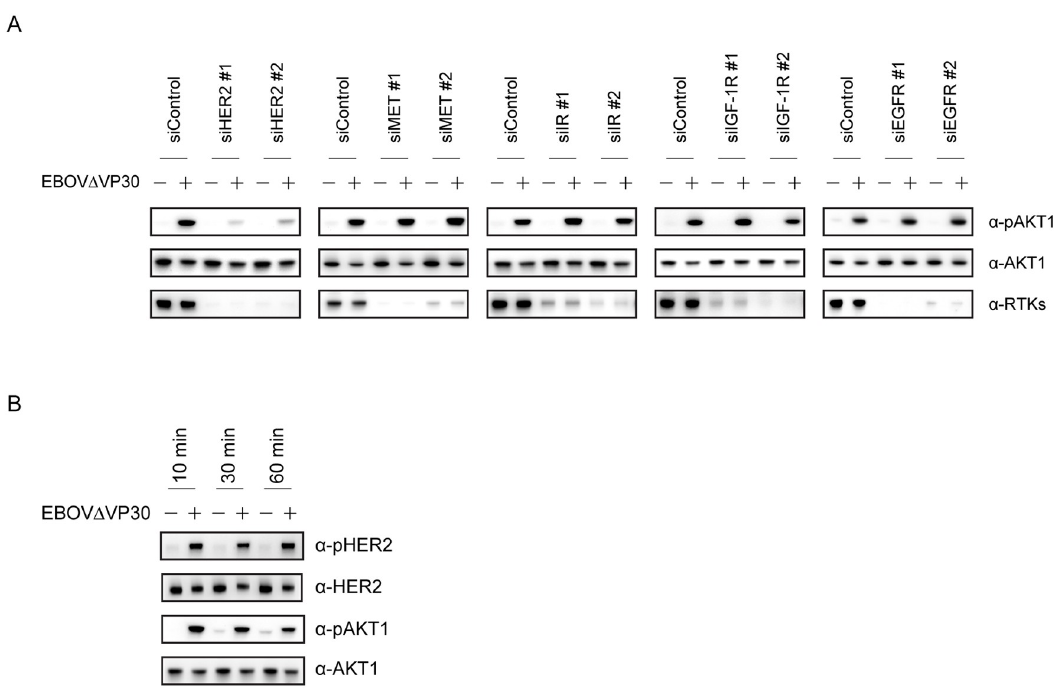
Fig 3. Reduction of AKT1 phosphorylation after HER2 knockdown in EBOV Δ VP30 -infected cells. (A) Phosphorylation levels of AKT1 in Huh7.0 VP30 cells after RTK knockdown. Cells were transfected with siRNAs targeting each RTK or control siRNA and then on day 3 post-transfection, were infected with EBOV Δ VP30 at an MOI of 3.0 for 30 min. The indicated protein expression levels were analyzed by immunoblotting. (B) Huh7.0 VP30 cells were infected with EBOV Δ VP30 at an MOI of 3.0 for the noted timepoints. The indicated protein expression levels were analyzed by immunoblotting.